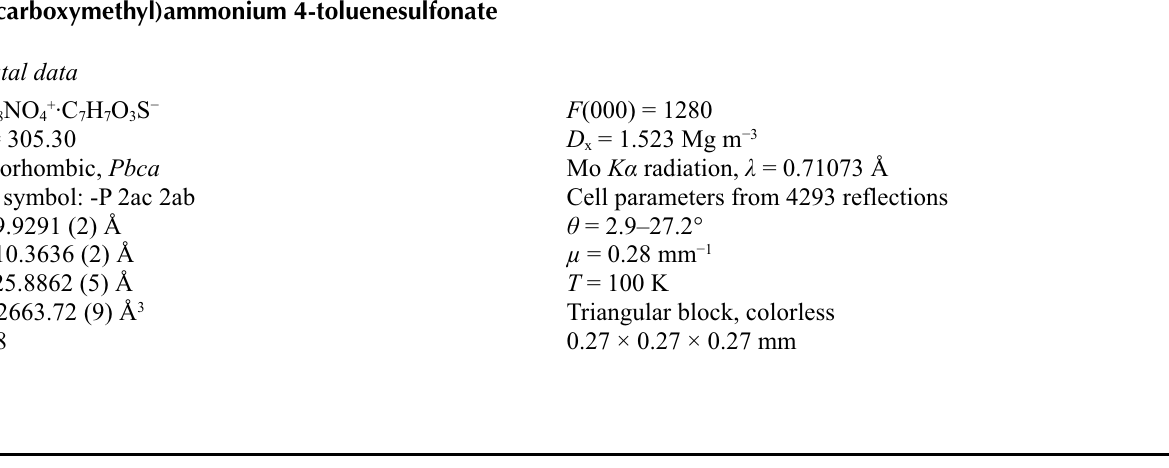
Thermal ellipsoid plot (Barbour, 2001) of (C as spheres of arbitrary